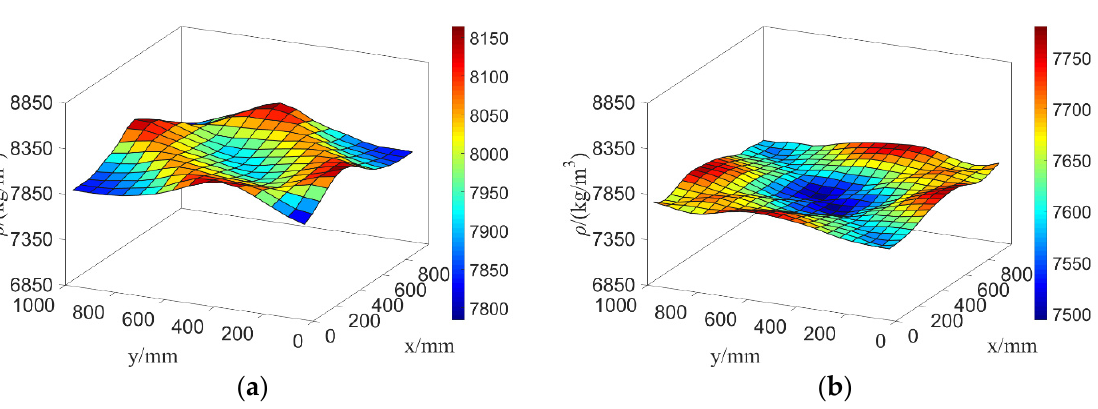
ρ in the plate in the case of 15 15